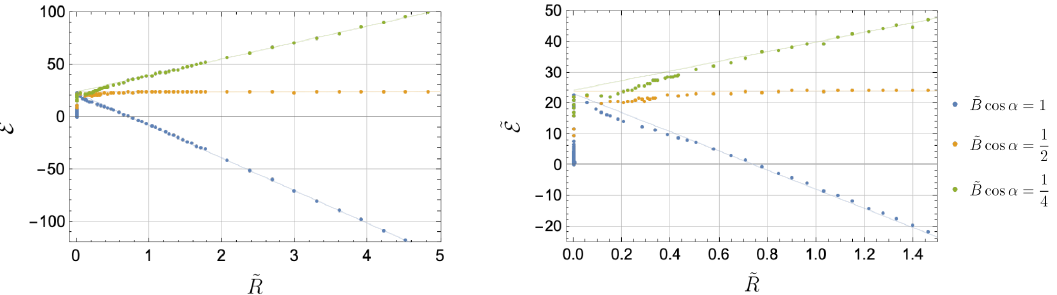
Figure 3 . The dimensionless total energy ˜ E is plotted as the function of the dimensionless radius ˜ R . Three different choices of ˜ B cos α = { 1 , 1 / 2 , 1 / 4 } corresponding to B ≥ B respectively, are shown. The right panel is the zoom-up around ˜ R = 0 of the left one.